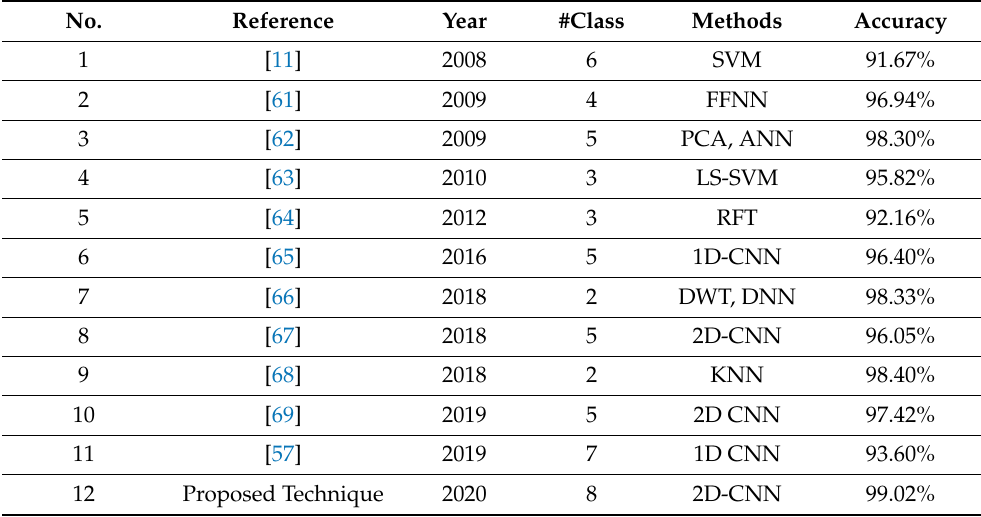
Table 4. Summarized performance evaluation results of different deep learning models on the MIT-BIH arrhythmia